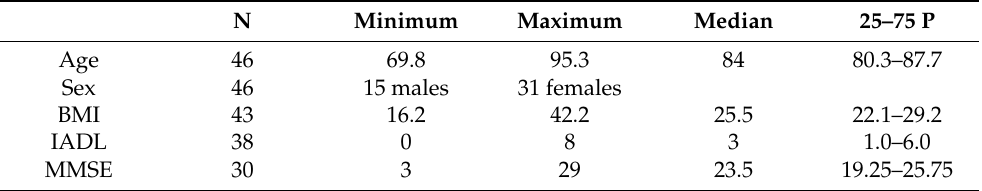
Table 1. Demographic and clinical characteristics of the population. Minimum, maximum and median values observed in the population were reported, as well as the 25th and 75th percentiles (25–75